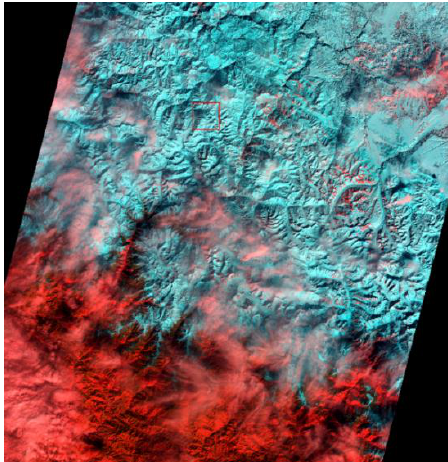
Figure 2. LISS-III image of ResourceSat-2. RGB distribution: 1.55-1.7µm, 0.77-0.86µm,